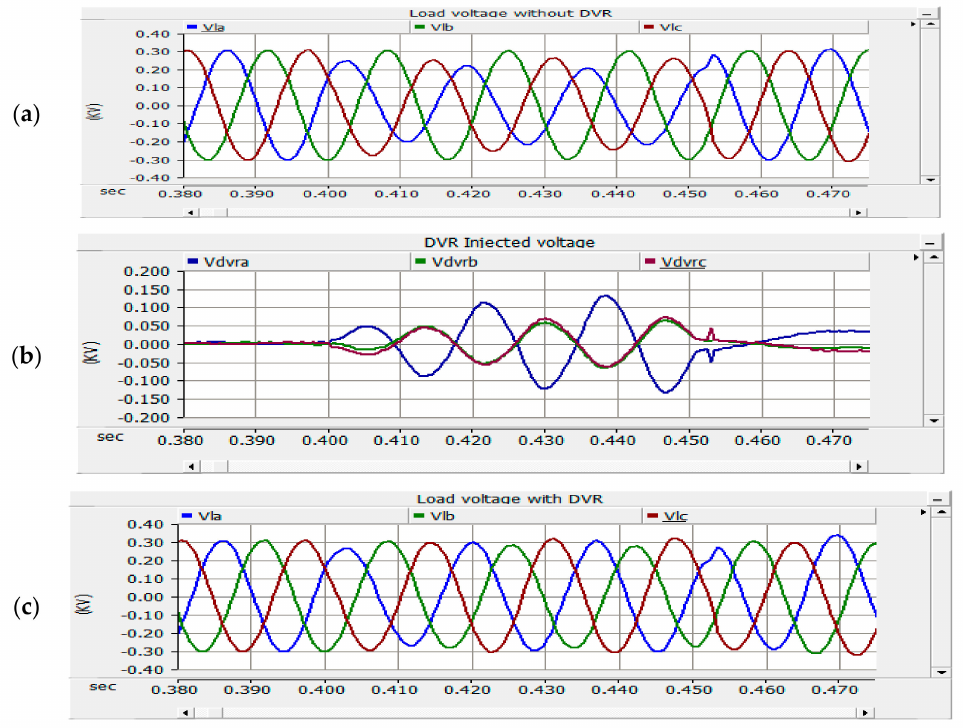
Figure 11. 33% double phase voltage sag and compensation: ( a ) load voltage without DVR; ( b ) DVR injected voltage; ( c ) load voltage with DVR.